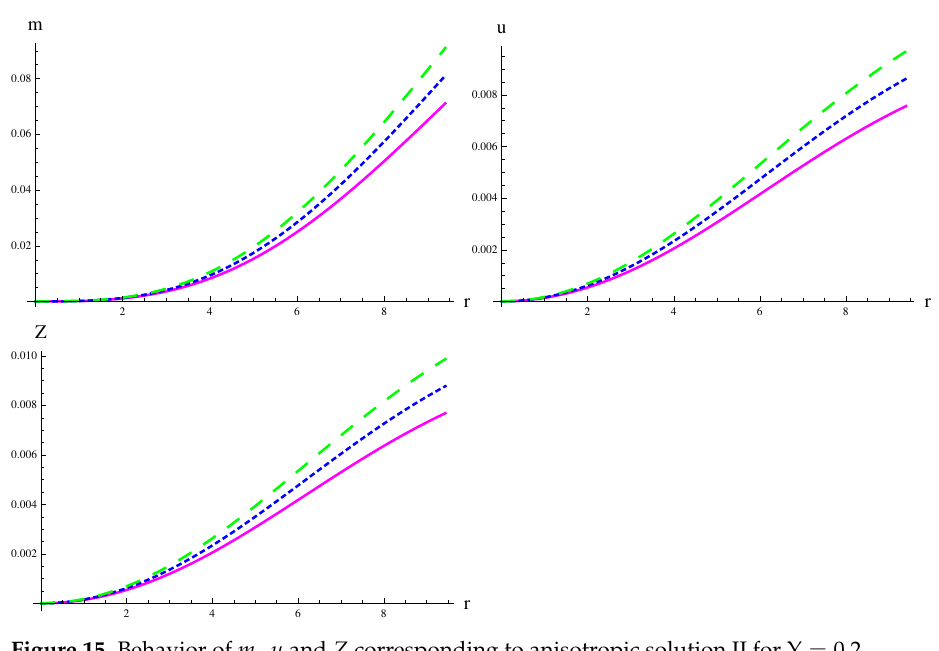
Figure 15. Behavior of m , u and Z corresponding to anisotropic solution II for Υ = 0.2.